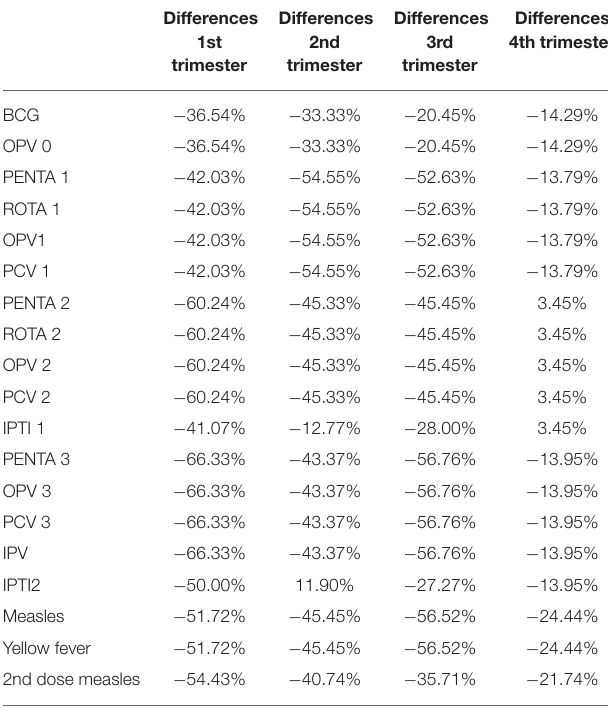
TABLE 1 | Differences in the number of vaccinations performed per trimester in the 2